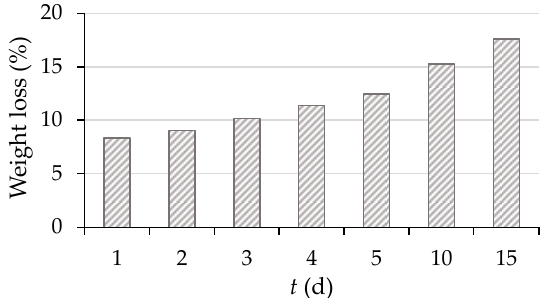
Figure 2. Substrate mass loss during SSF (1–5, 10, 15 day) by R. oryzae in laboratory jars.